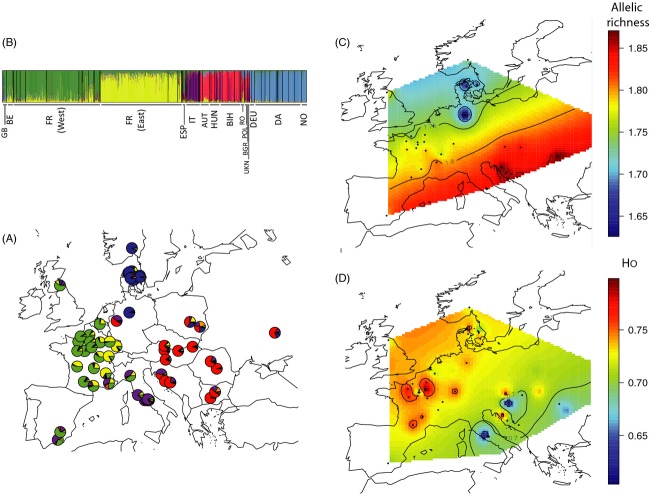
Geographical genetic diversity, genetic structure, and admixture of Malus sylvestris in Europe (A) Population structure for the nonintrogressed Malus sylvestris dataset (N = 1376, 62 sites), inferred with TESS, for Kmax = 8, showing five distinct genetic clusters. Each vertical line represents an individual. Individuals were grouped by country. Colors represent the inferred ancestry from K ancestral populations. For clarity, the 62 sites are grouped by country: GB: Great Britain, BE: Belgium, FR (West): Western France, FR (East): Eastern France, ESP: Spain, IT: Italy, AUT: Austria, HUN: Hungary, BIH: Bosnia Herzegovina, RO: Romania, POL: Poland, BGR: Bulgaria, UKN: Ukraine, DEU: Germany, DA: Denmark, NO: Norway; (B) Map representing the mean membership proportions inferred by TESS for the five detected clusters, for samples of Malus sylvestris collected from the same site (62 sites across Europe). (C) and (D) Maps of interpolated allelic richness AR and observed heterozygosity HO, respectively, across Europe.